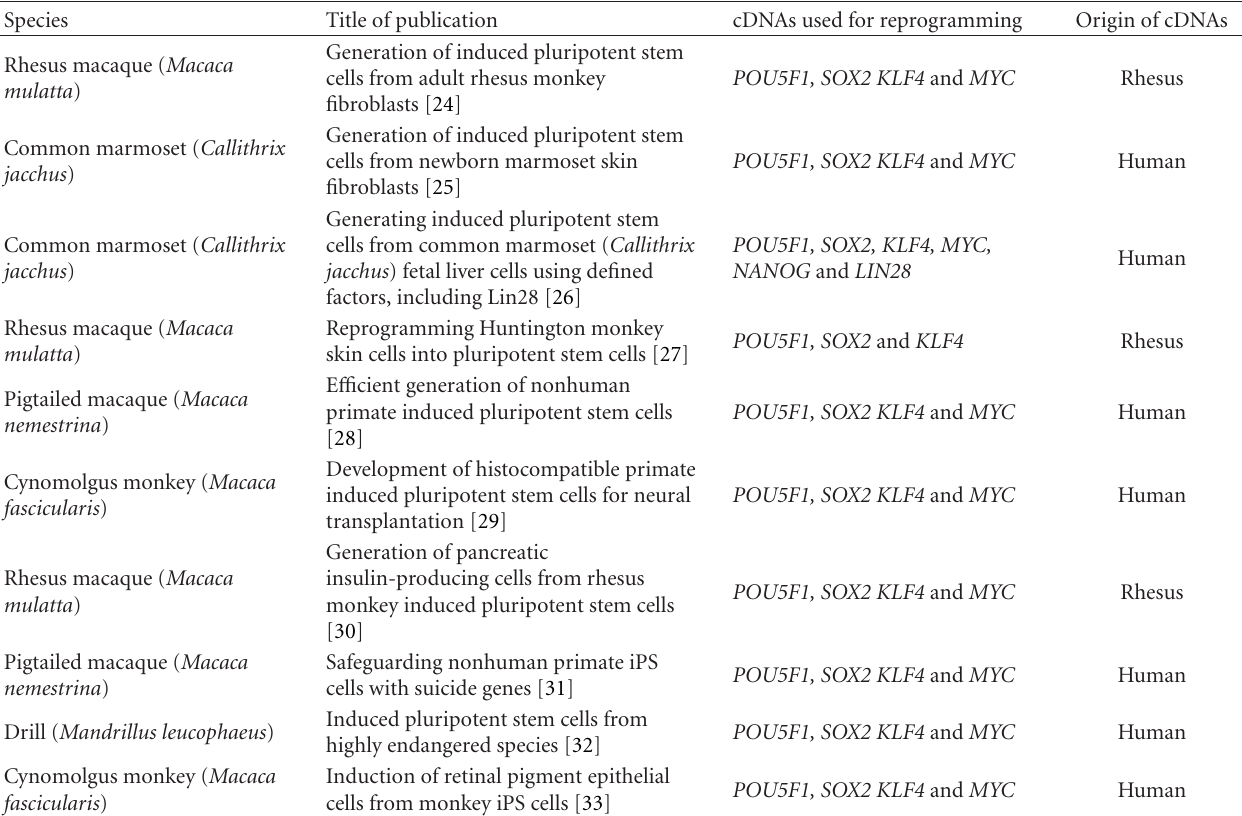
Table 1: Publications on nonhuman primate iPS